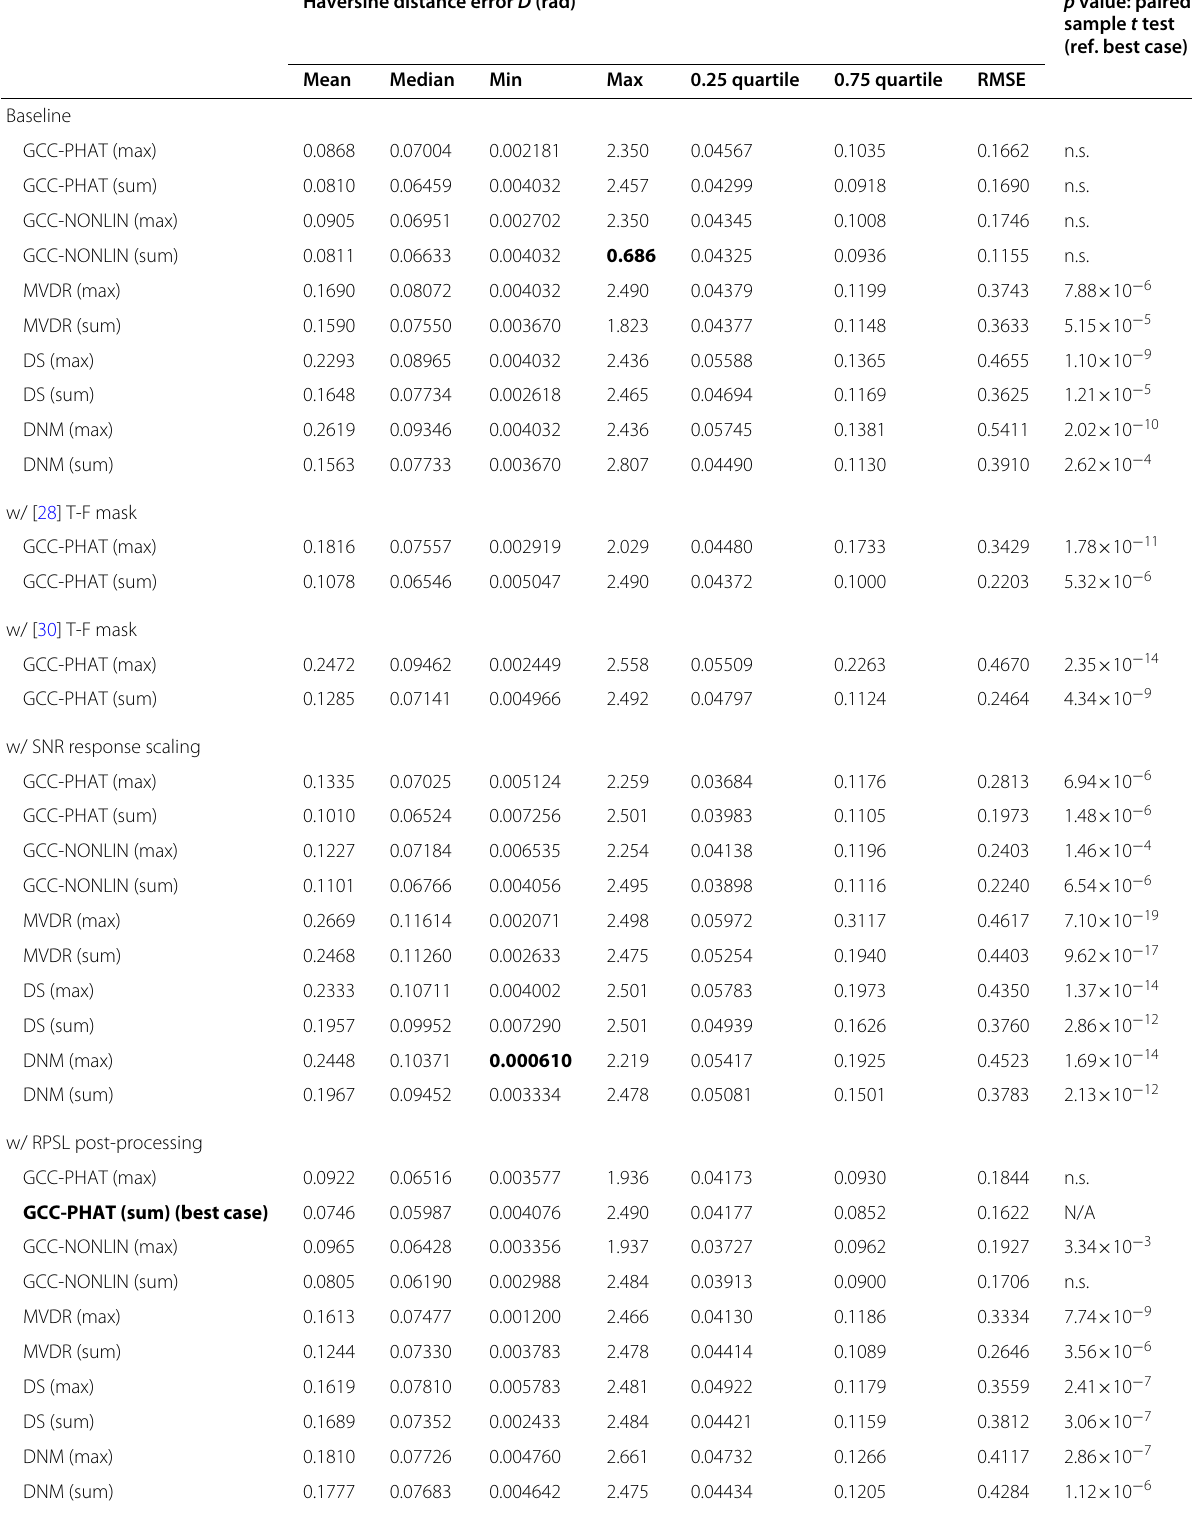
Table 4 Haversine distance error performance comparison (task 2—flying UAV, broadband sound